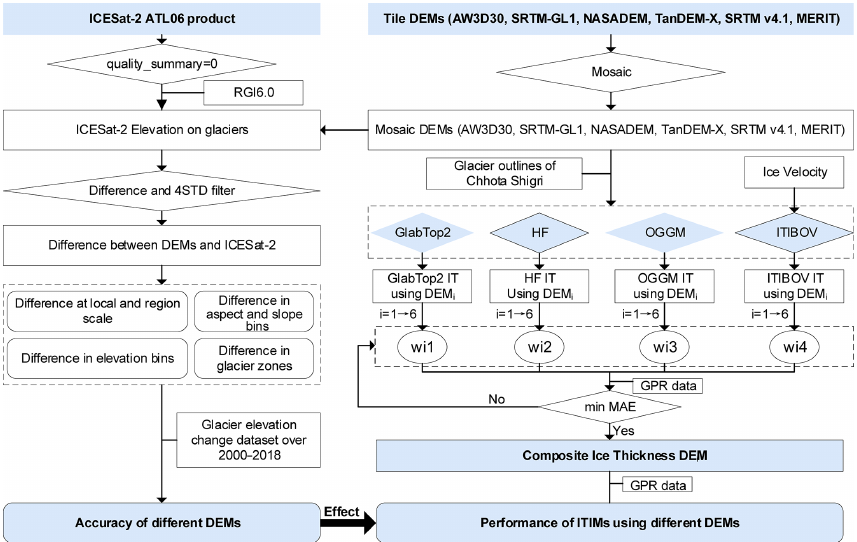
Figure 2. Flow chart showing the targets and methods used in this study including an accuracy evaluation of DEMs and their effects on ice-thickness inversion models. The abbreviations wi1, wi2, wi3, and wi4 denote the weight of each modeled ice thickness; i from 1 to 6 denotes six different DEMs; and the number 1–4 denotes the four ice-thickness inversion models. 4STD: 4 standard deviations. IT: ice